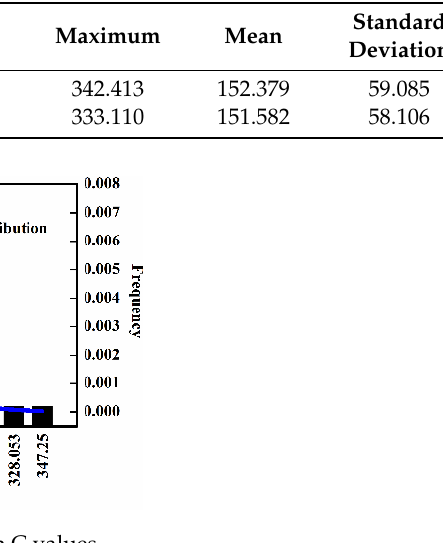
Table 1. Statistical vitamin C values (mg/100 g) determined by official method.